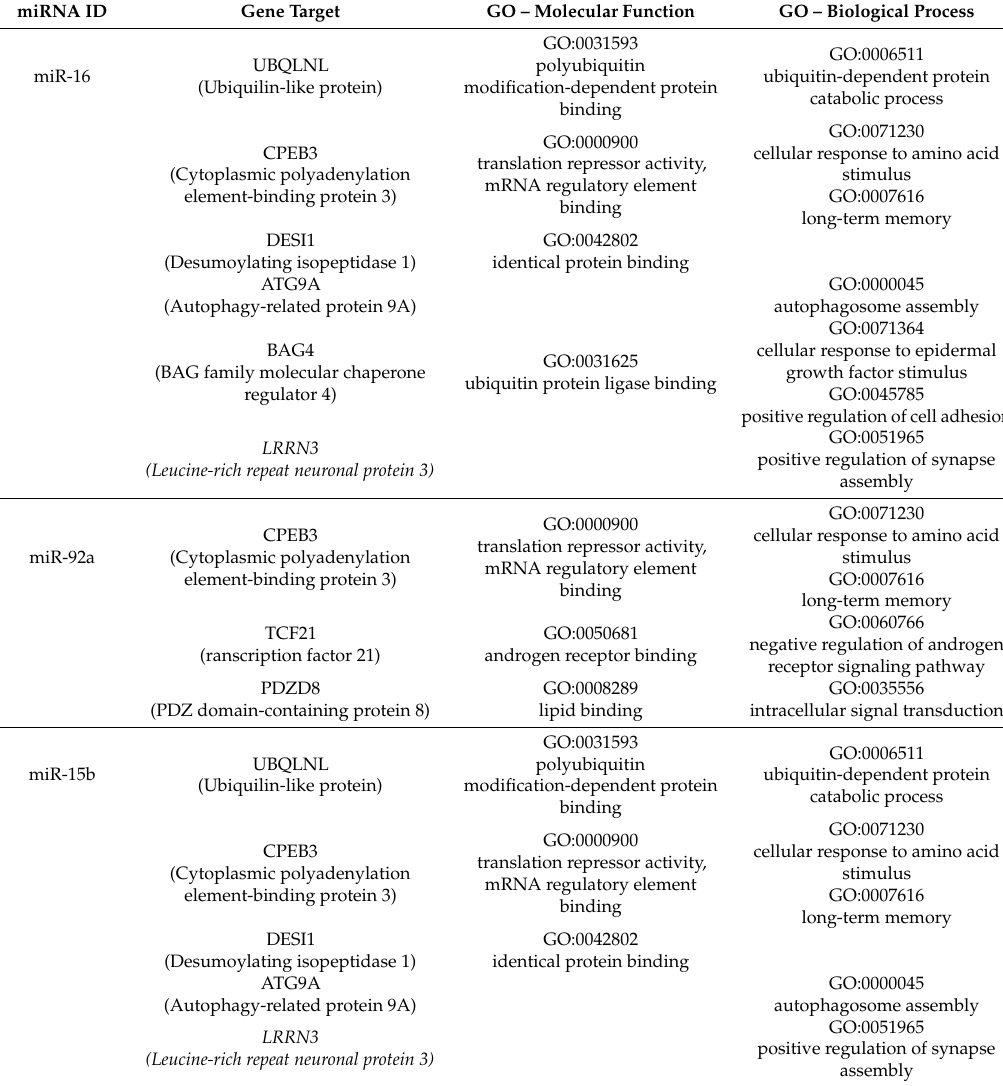
Table 4. Target genes of the 10 miRNA Sus scrofa -specific miRNAs detected by the GeneChip ™ miRNA 4.0 Array (ThermoFisher Scientific) expressed more than 10 times average expression units (log2 average expression or transcript detection average expression units; experiment 1) in relation to the DEGs using a microarrays platform (GeneChip ® Porcine Gene 1.0 ST Array) of 521 transcripts between high- and low-fertile boars (experiment 2). Up-regulated in bold and down-regulated in italics. miRNA